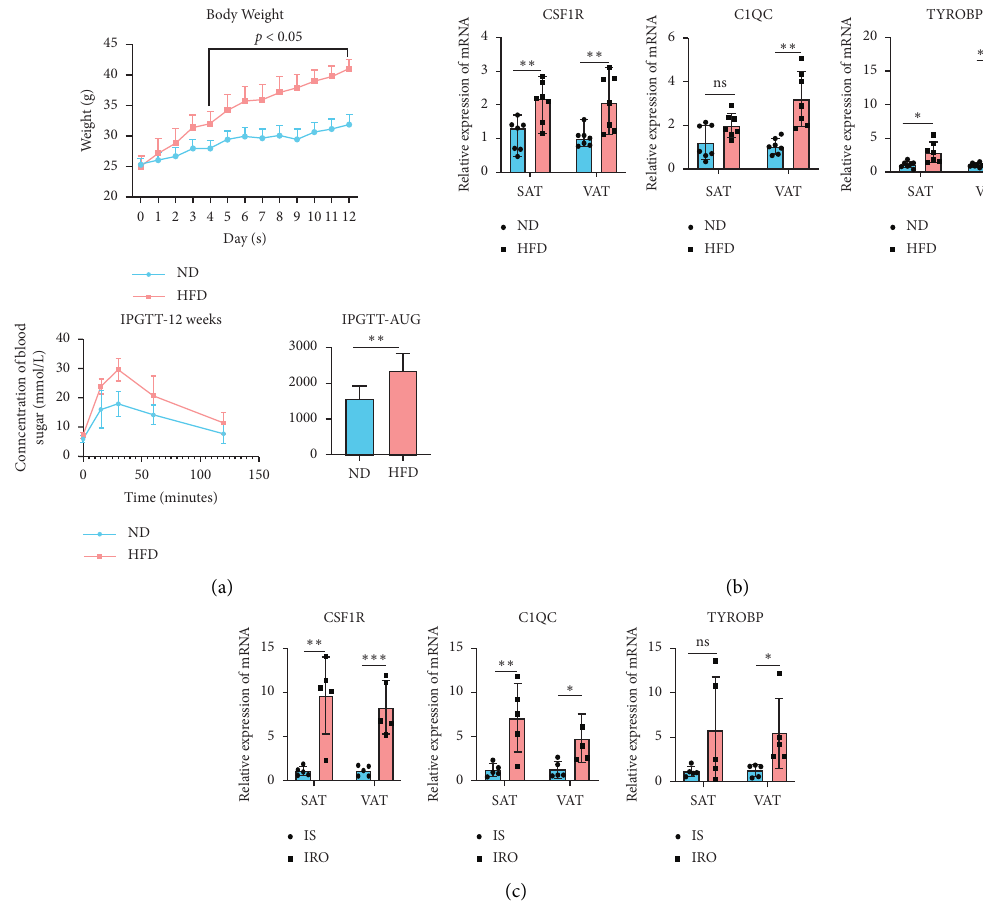
Figure 6: Hub genes’ upregulation in AT was accompanied with process of obtained obesity-induced IR. Validation of CSF1R , C1QC , and TYROBP gene expressions levels by using RTqPCR. (a) Body weight curves of HFD feeding ( n � 7) and ND feeding controls ( n � 7) mice. Glucose tolerance tests (GTT) were performed in HFD fed mice and ND fed mice after 12 weeks feeding period. (b) mRNA expression levels of the top 3 hub genes in adipose tissue of SAT or VAT from HFD feeding mice and ND feeding control mice after 12 weeks ( n � 7). (c) mRNA expression levels of the top 3 hub genes in adipose tissue of SATor VATfrom IRO patients and IS controls ( n � 5). Unpaired two- sided t test, ∗ P value < 0.05. ∗∗ P value < 0.01. ∗∗∗ P value < 0.001. n.s. � not